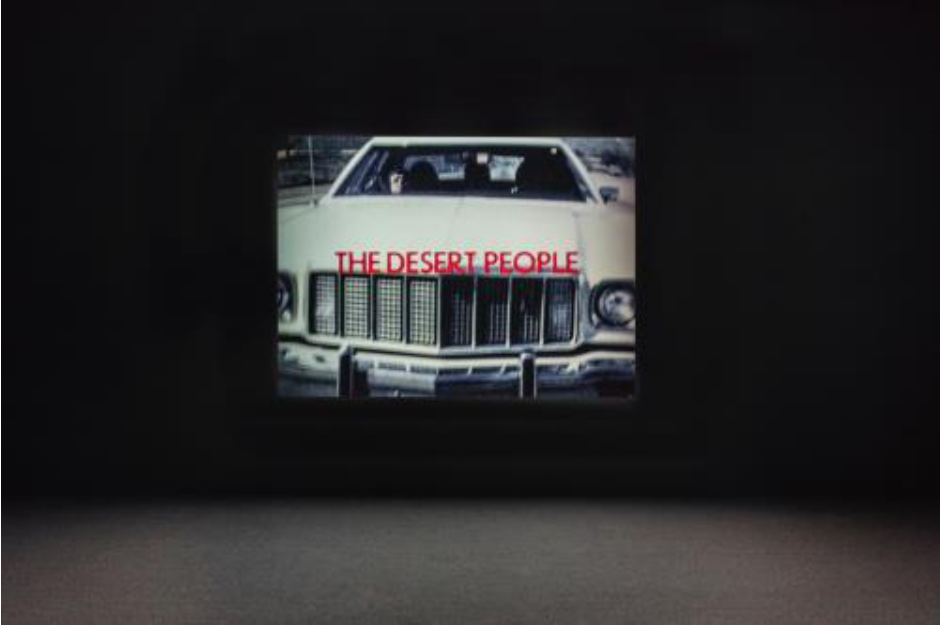
The accompanying soundtrack of funky beats and tangy electronics, shrieking tires, an d roaring engines, paired with a camera that caresses the Gran Torino’s glinting body as